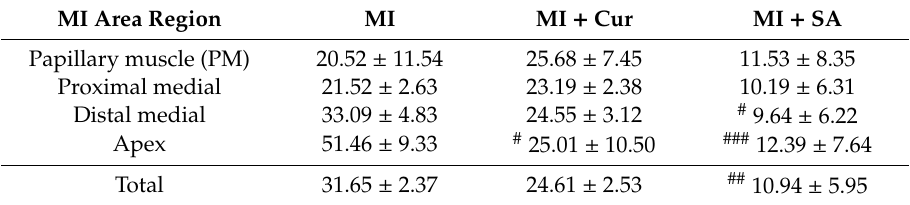
Table 1. Myocardial infarct size (%) in each MI area region measured by TTC